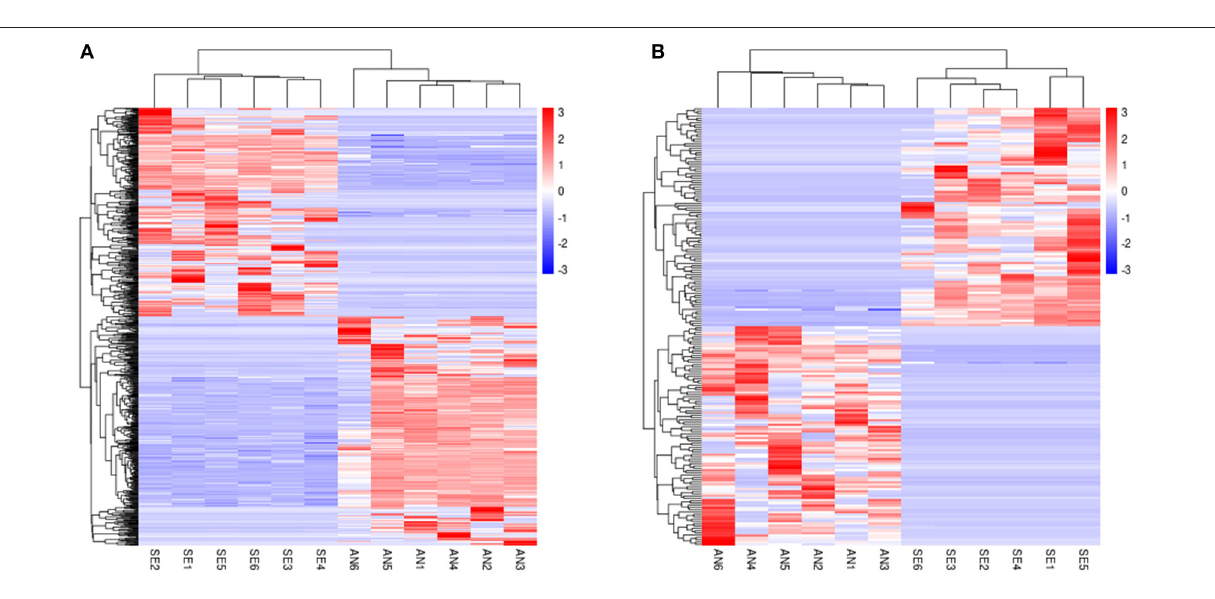
FIGURE 3 | Heat map of DE mRNAs (A) and DE lncRNAs (B)